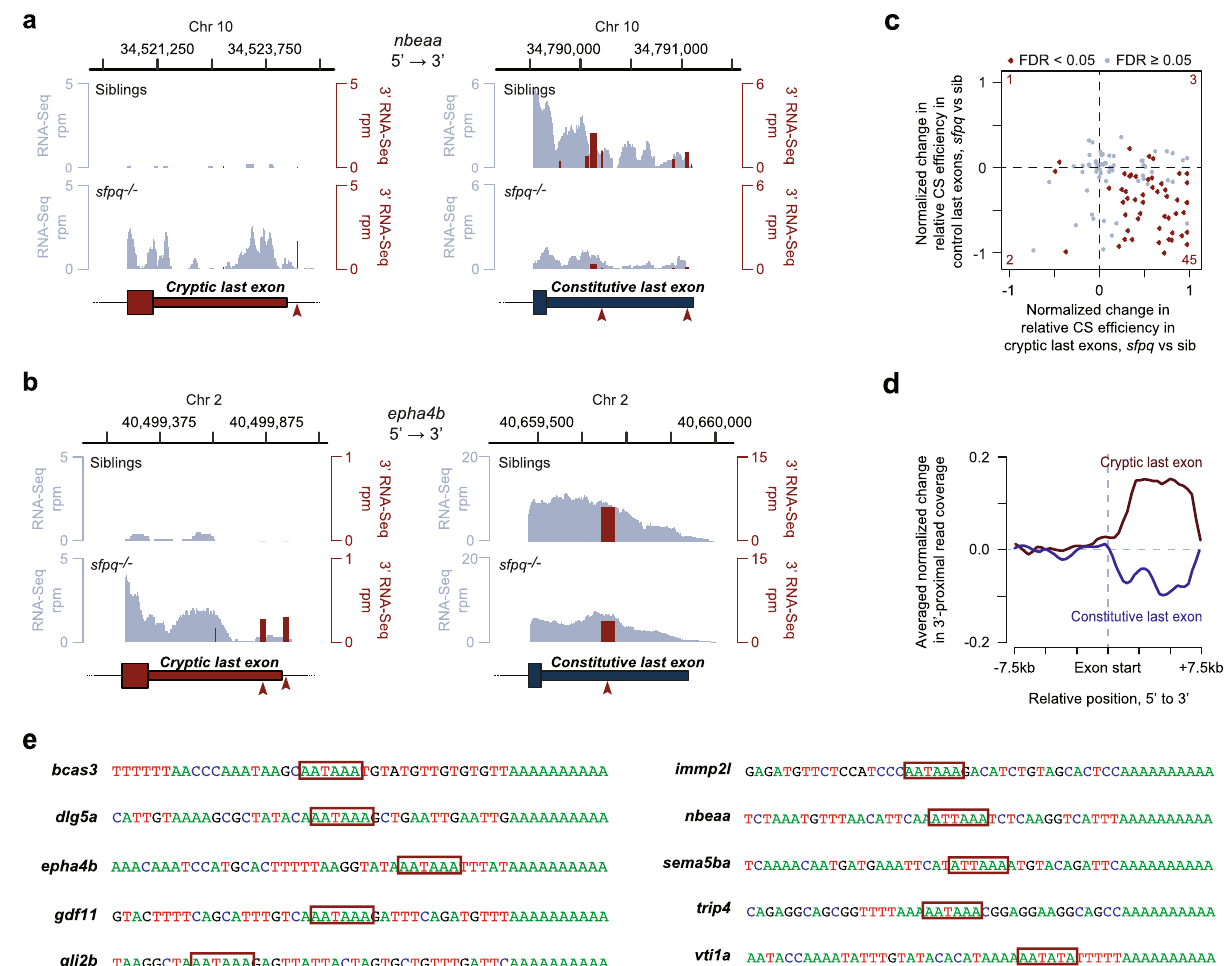
Fig. 2 CLEs are cleaved and polyadenylated. a , b Representative coverage plots from RNA-seq (light blue) and 3 ′ mRNA-seq (red) experiments showing cryptic last and constitutive last exons. Only clustered reads are shown in the 3 ′ mRNA-seq pro fi le and consensus polyadenylation signals (PASs) are marked by red arrowheads. c Four-way dot plot representing the change in relative cleavage site usage (sfpq vs sib) for CLEs ( x -axis) against its corresponding constitutive last exons ( y -axis; control). A positive value on each axis represents an increased CS usage in sfpq − / − null. Genes showing signi fi cantly changing CS usage in both CLE and control (FDR < 0.05) are colored red and the total number of signi fi cantly regulated genes is indicated for each quadrant. d Metaplot of the normalized change in 3 ′ mRNA-seq coverage within regions surrounding CLEs (red) and constitutive last exons